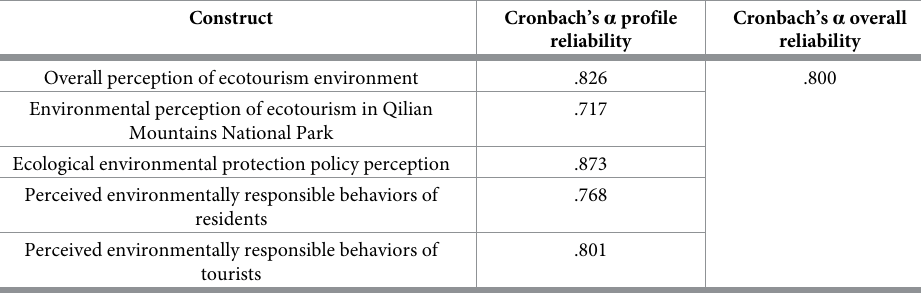
Table 6. Reliability of tourists’ questionnaire.